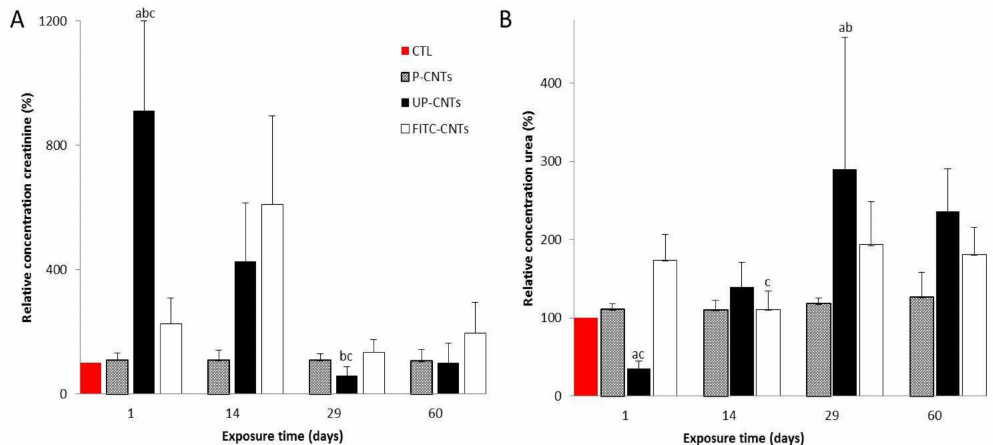
Figure 8. E ff ect of exposure to di ff erent CNTs on levels of urea and creatinine. Graphics show relative concentration of A, urea and B, creatinine, at 1, 14, 29, and 60 days post exposure. Each bar represents the mean ± SE of each group ( n = 4). a: di ff erence with respect to the control without stimulus ( p < 0.05). b: di ff erence among treatments ( p < 0.05), and c: di ff erence among times post exposure ( p <